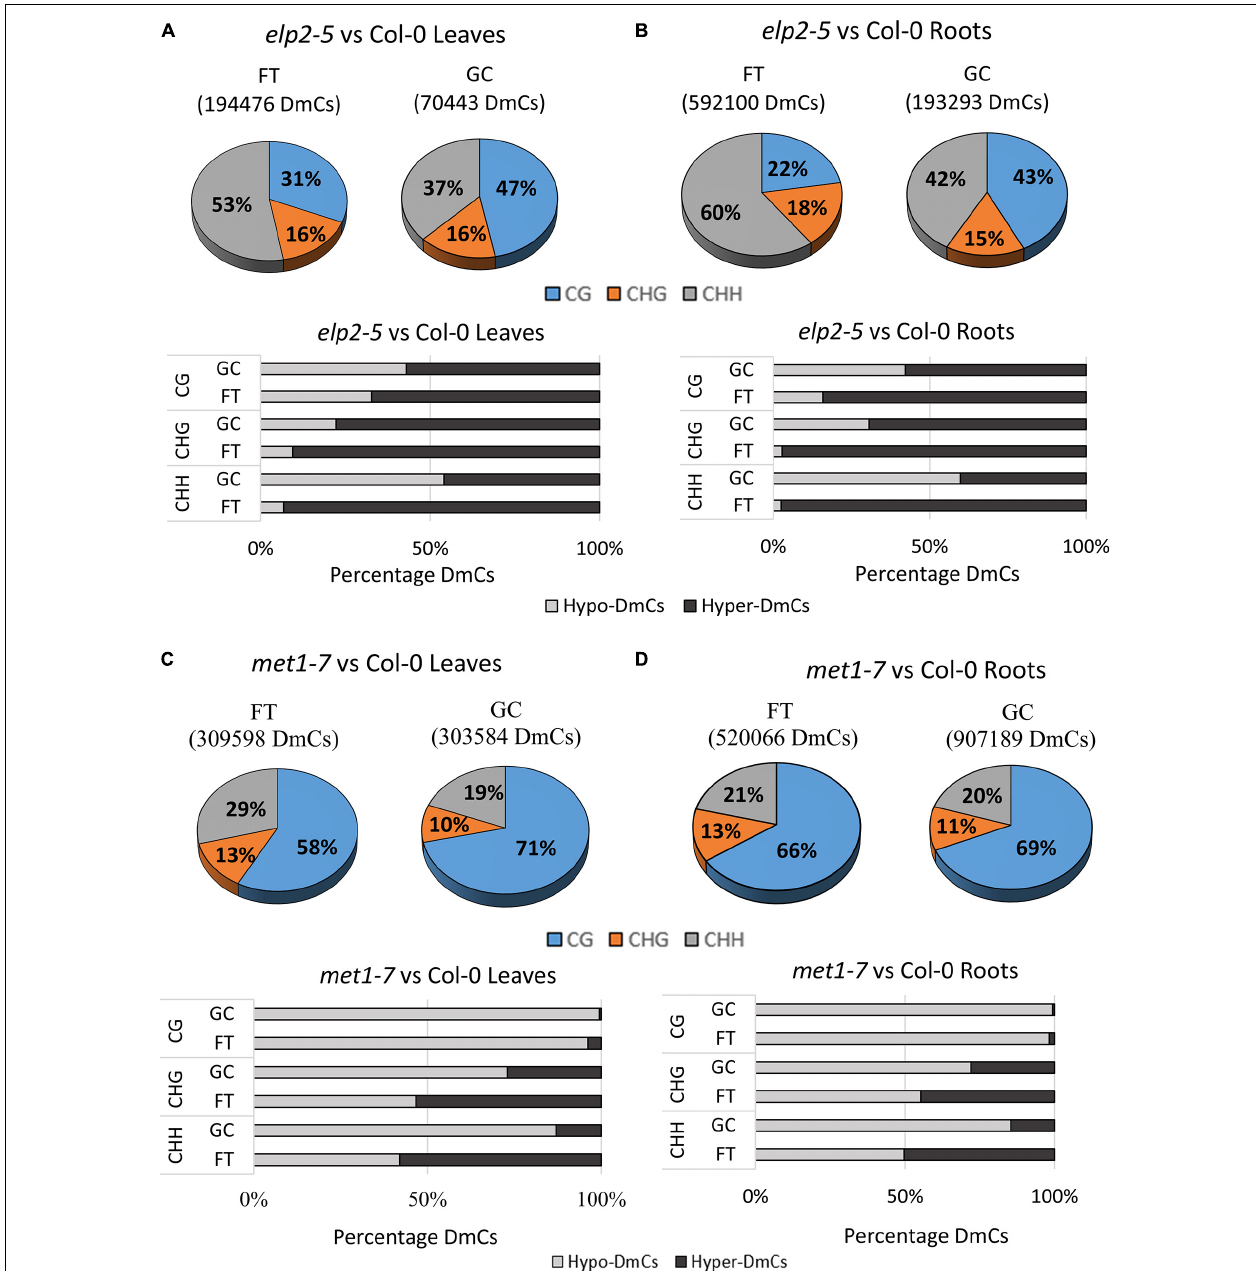
FIGURE 4 | Differentially methylated cytosines (DmCs) of leaves and roots from each genotype in response to spaceflight. (A) Breakdown of each methylation context for DmCs in leaves and roots of Col-0, elp2 , and met1-7 in spaceflight compared to ground control. (B) Total number of DmCs broken down in each context for all three genotypes in leaves and roots. (C) Breakdown of the methylation direction of total leaf DmCs in each context – Hypomethylation (Hypo) gray and Hypermethylation (Hyper) black. (D) Breakdown of the methylation direction of total root DmCs in each context.